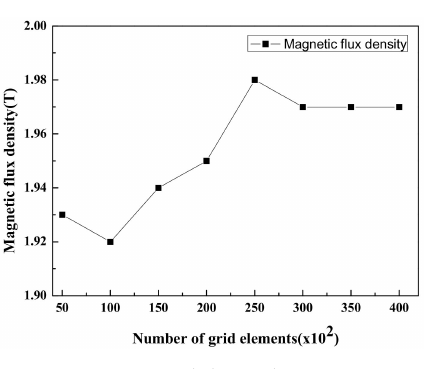
Figure 2. Schematic of the grid systems.